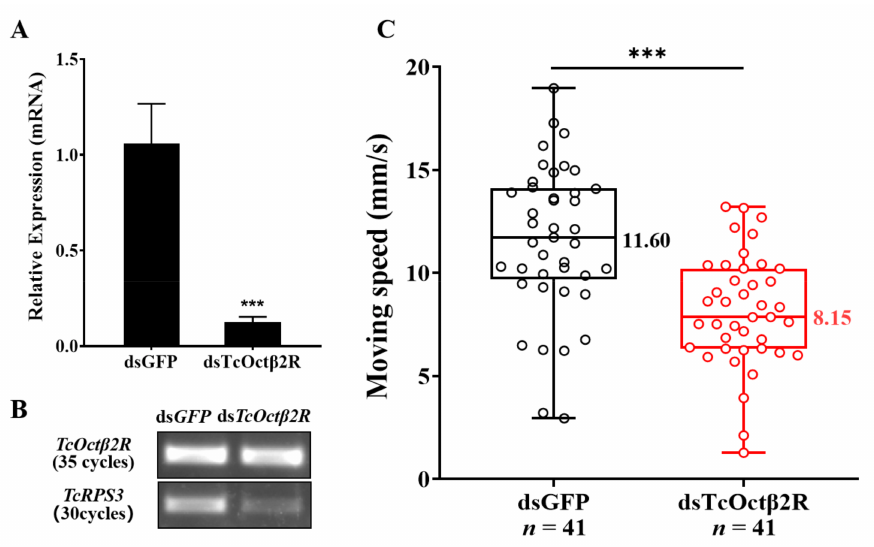
Figure 5. RNAi of TcOct β 2R and mobility assay: ( A ) RNAi efficiency tested by qRT-PCR; ( B ) the confirmation of RNAi efficiency by RT-PCR; ( C ) moving speed (in millimeters per second) of T. castaneum . Asterisks represent the significant difference in independent t -test ( n = 41, *** p <